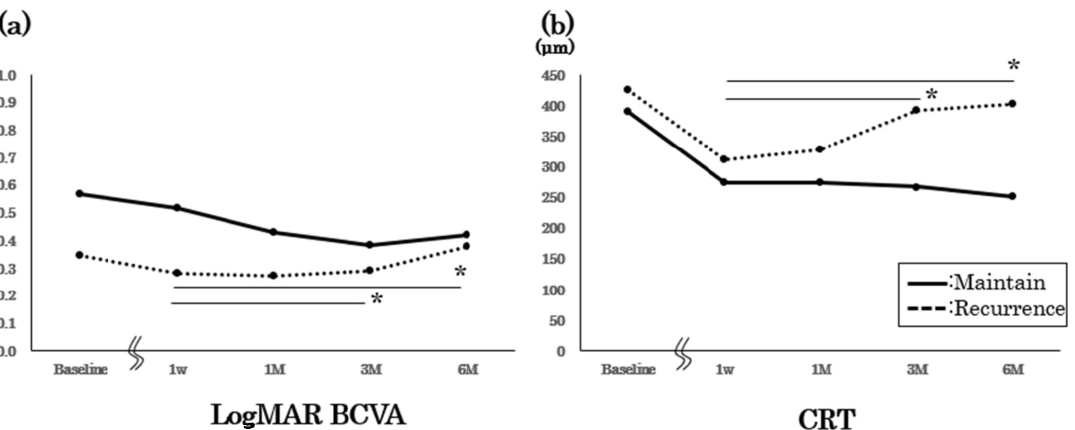
Figure 3. BCVA and CRT changes after the loading injections in the maintained and recurrence groups. Six-month changes after the loading injections for Log MAR BCVA ( a ) and CRT ( b ). BCVA: best-corrected visual acuity; CRT: central retina thickness. *: p < 0.05, repeated ANOVA.